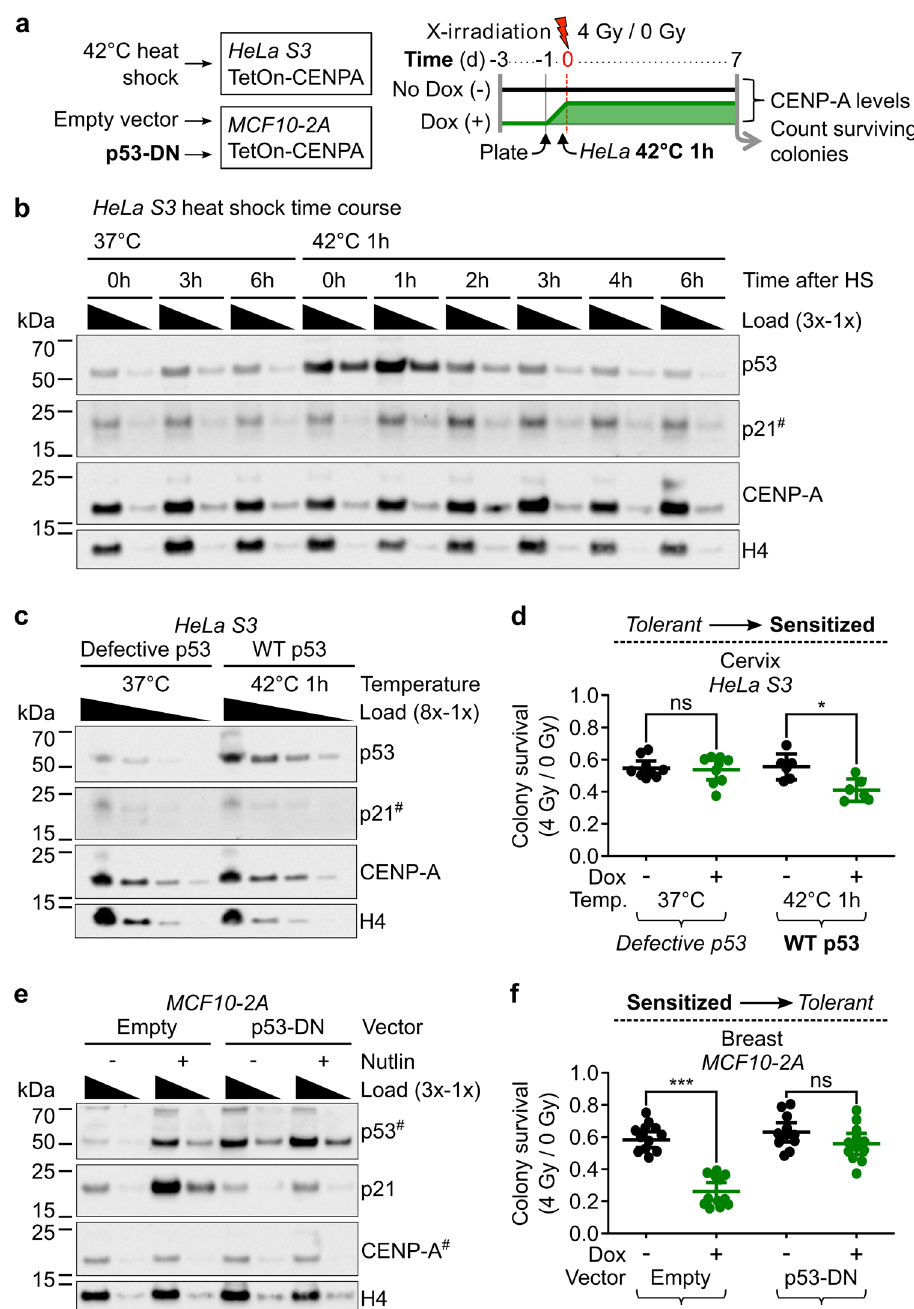
Fig. 3E, including numerical and structural aneuploidy by mul- ticolor fl uorescence in situ hybridization (mFISH)